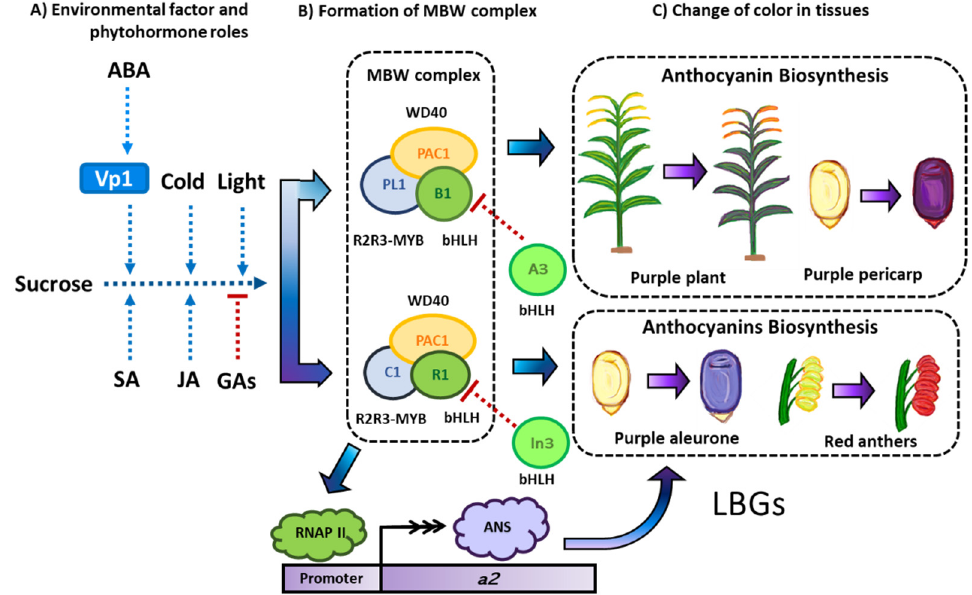
Figure 6. The regulation of the MBW complex and its influence on anthocyanin biosynthesis . ( A ) Environmental factors such as ultraviolet light (UV) and cold temperatures and phytohormones